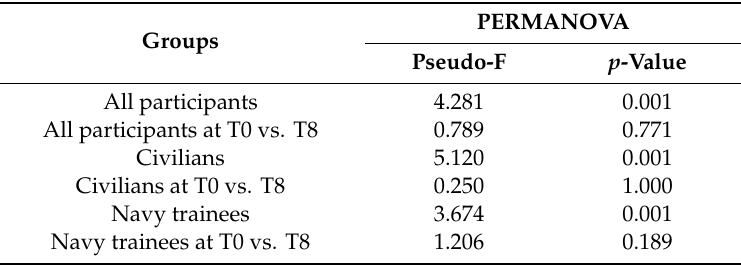
Table 3. Permutational multivariate analysis of variance (PERMANOVA) table showing the significant e ff ect of individuals in comparison with lifestyle factors on gut